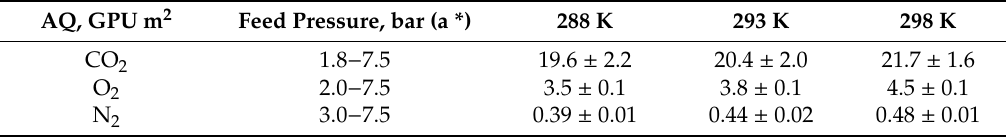
Table 1. Module permeance of carbon dioxide, nitrogen, and oxygen in UBE UMS-A5.